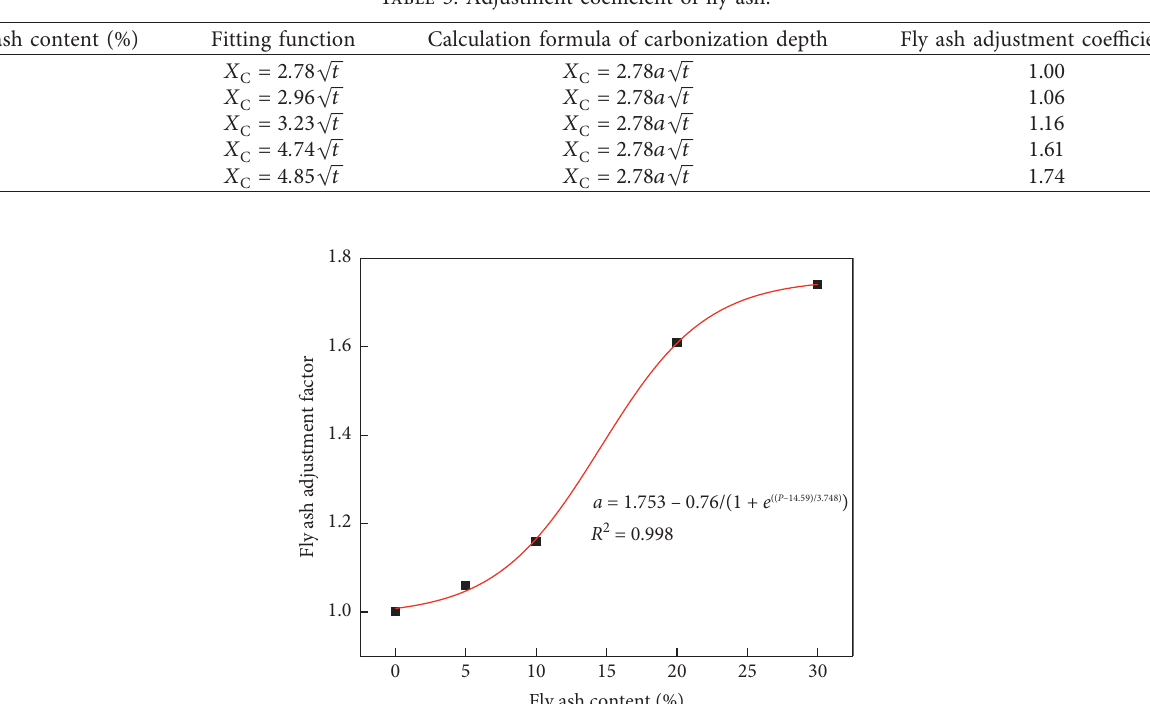
Table 5: Adjustment coefficient of fly ash.